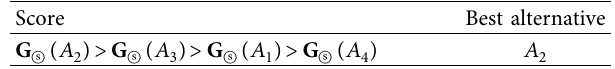
Table 17: Ranking of the